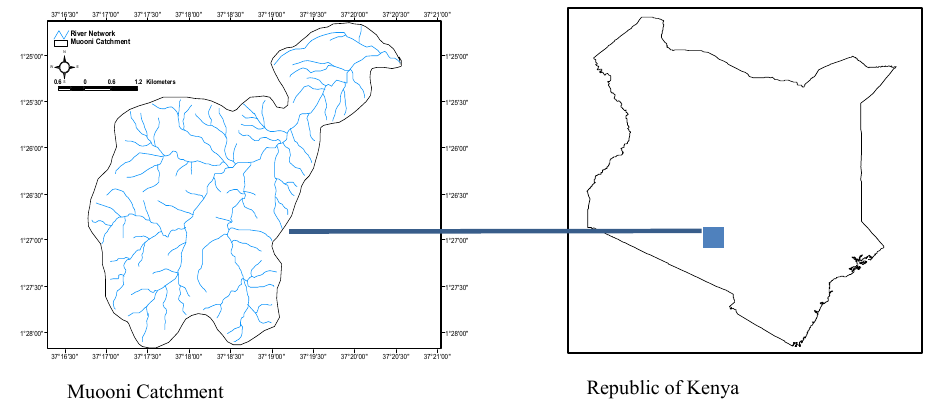
Figure 1. Muooni catchment area in the map of Kenya and East Africa [14].